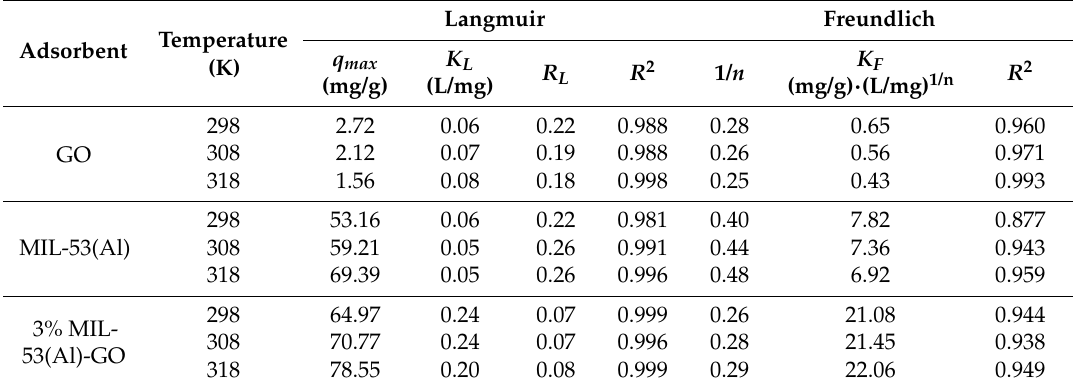
Table 2. Isotherm parameters of As(III) adsorption on MIL-53(Al), GO, and 3% MIL-53(Al)-GO nanocomposite. Langmuir Temperature Adsorbent (K)